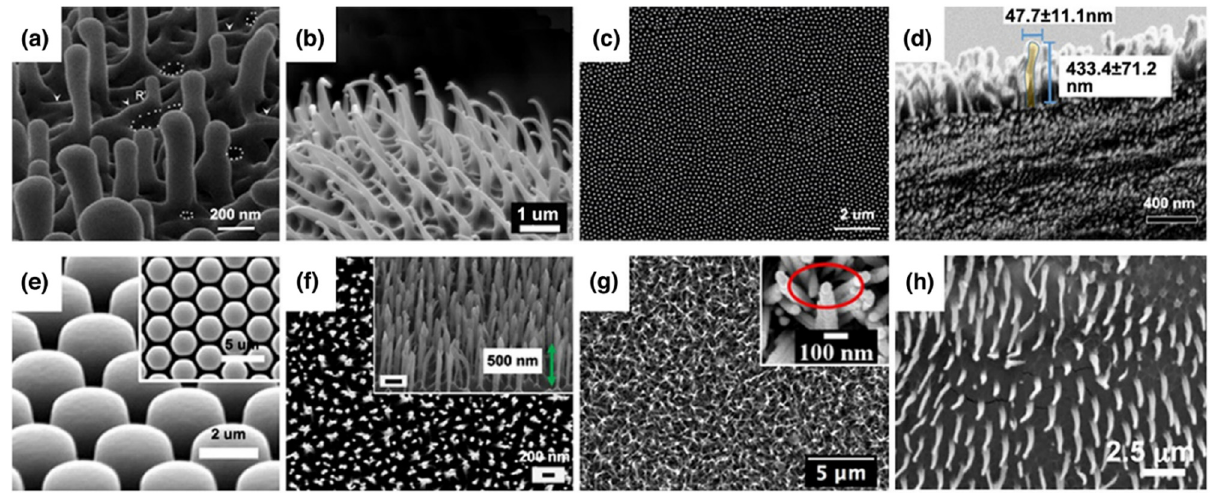
Figure 18: SEM images of some ( a – d ) natural bactericidal nanotopography and ( e – h ) synthetic bactericidal nanotopography [ 131 ] . Copy - right 2021, Elsevier ™